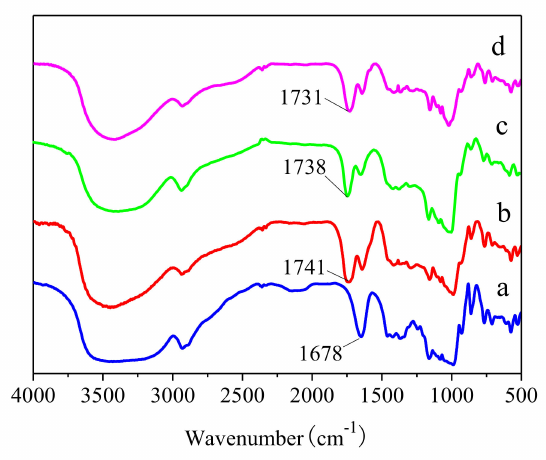
Figure 3. FTIR spectra of malate starch samples: ( a ) Native pea starch, ( b ) malate starch, ( c ) HMT-malate starch, and ( d ) malate-HMT